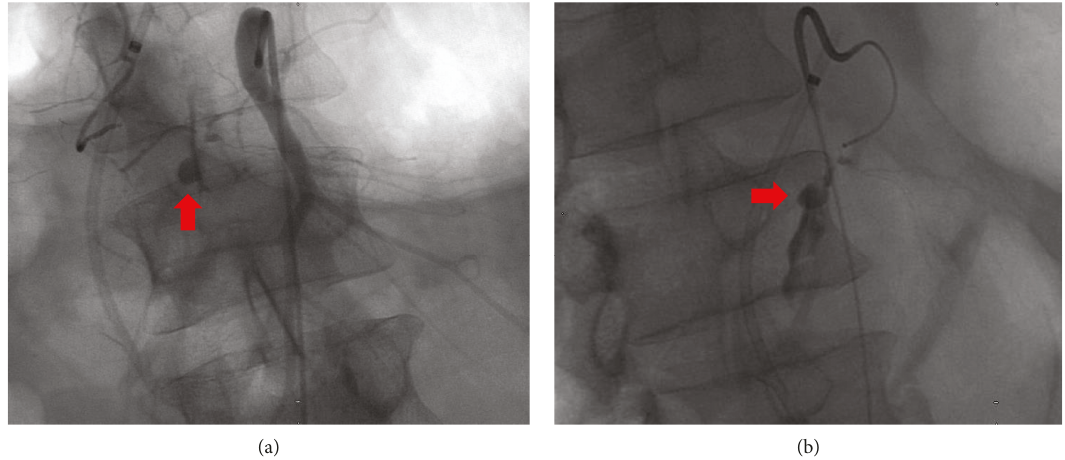
Figure 2: Angiography. (a) Superior mesenteric arteriogram showing pseudoaneurysm at the IPDA (red arrow). (b) Selective catheterization of the IPDA showing active extravasation into the pancreatic duct from the IPDA pseudoaneurysm (red